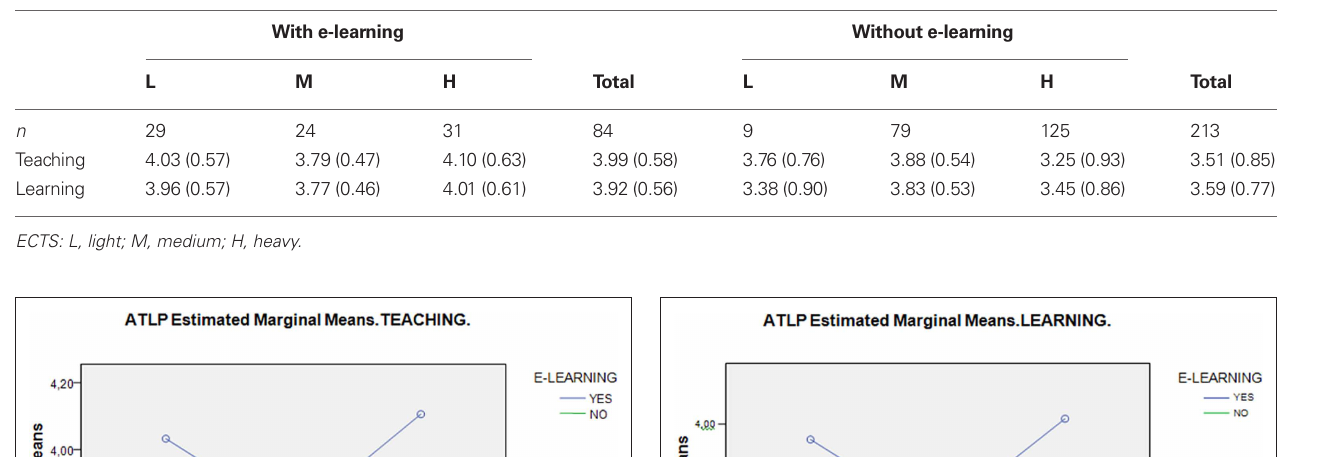
Table 3 | Mean values for TLP satisfaction, according to ECTS credit load and e-learning.